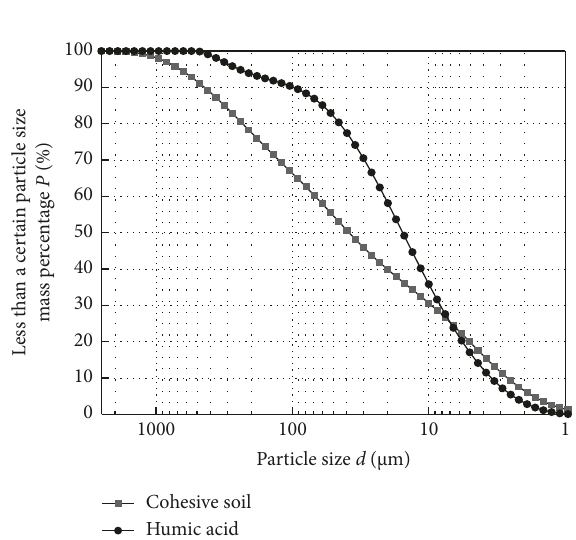
Figure 1: Cumulative particle size curve of test